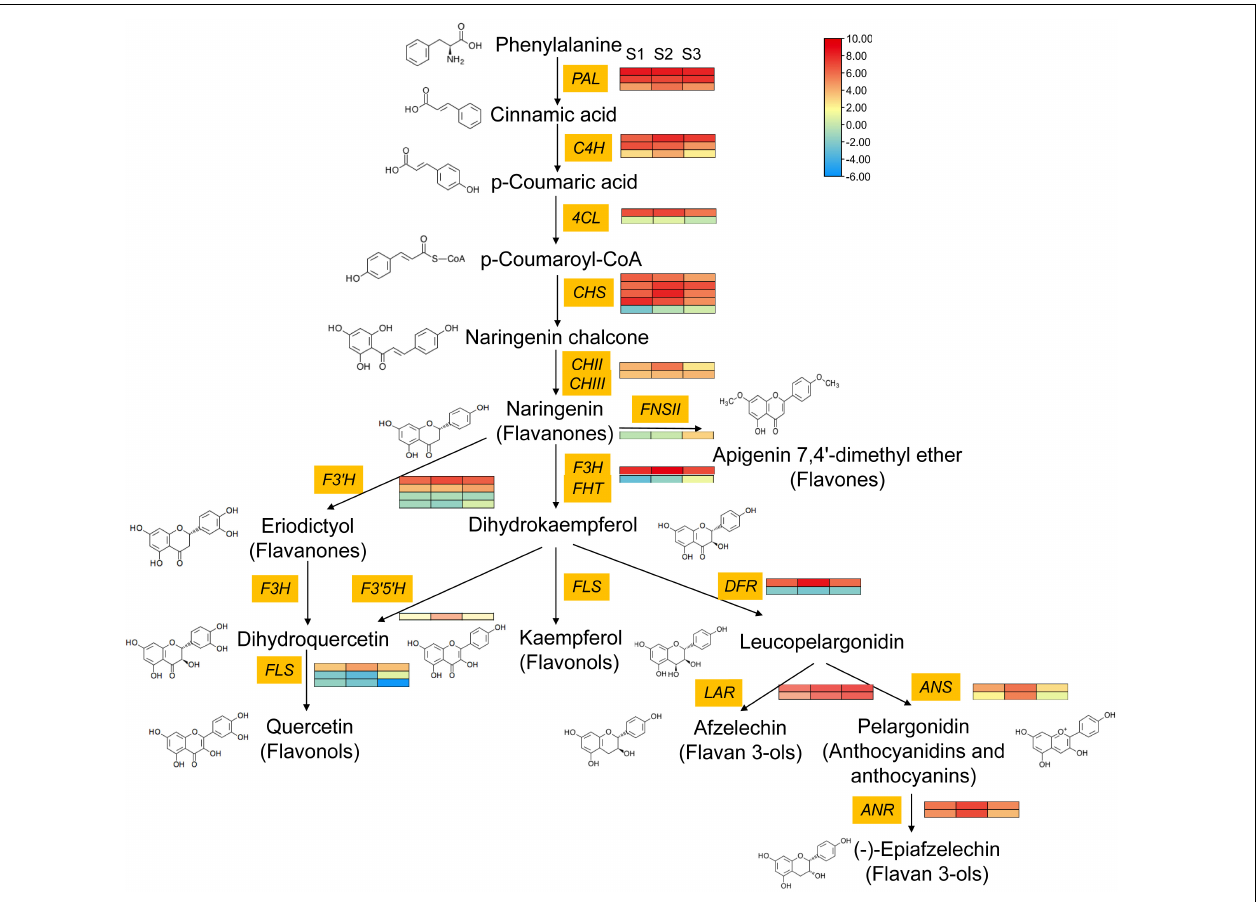
FIGURE 6 | Comparative transcriptomic analysis of structural genes involved in the flavonoid biosynthesis pathway at different stems. The three columns for each gene represent the expression level at S1, S2, and S3 stage, respectively. Red represents the high expression level; blue represents the low expression level. Stem_young, stem_older, and stem_oldest were re-named as S1, S2, and S3,